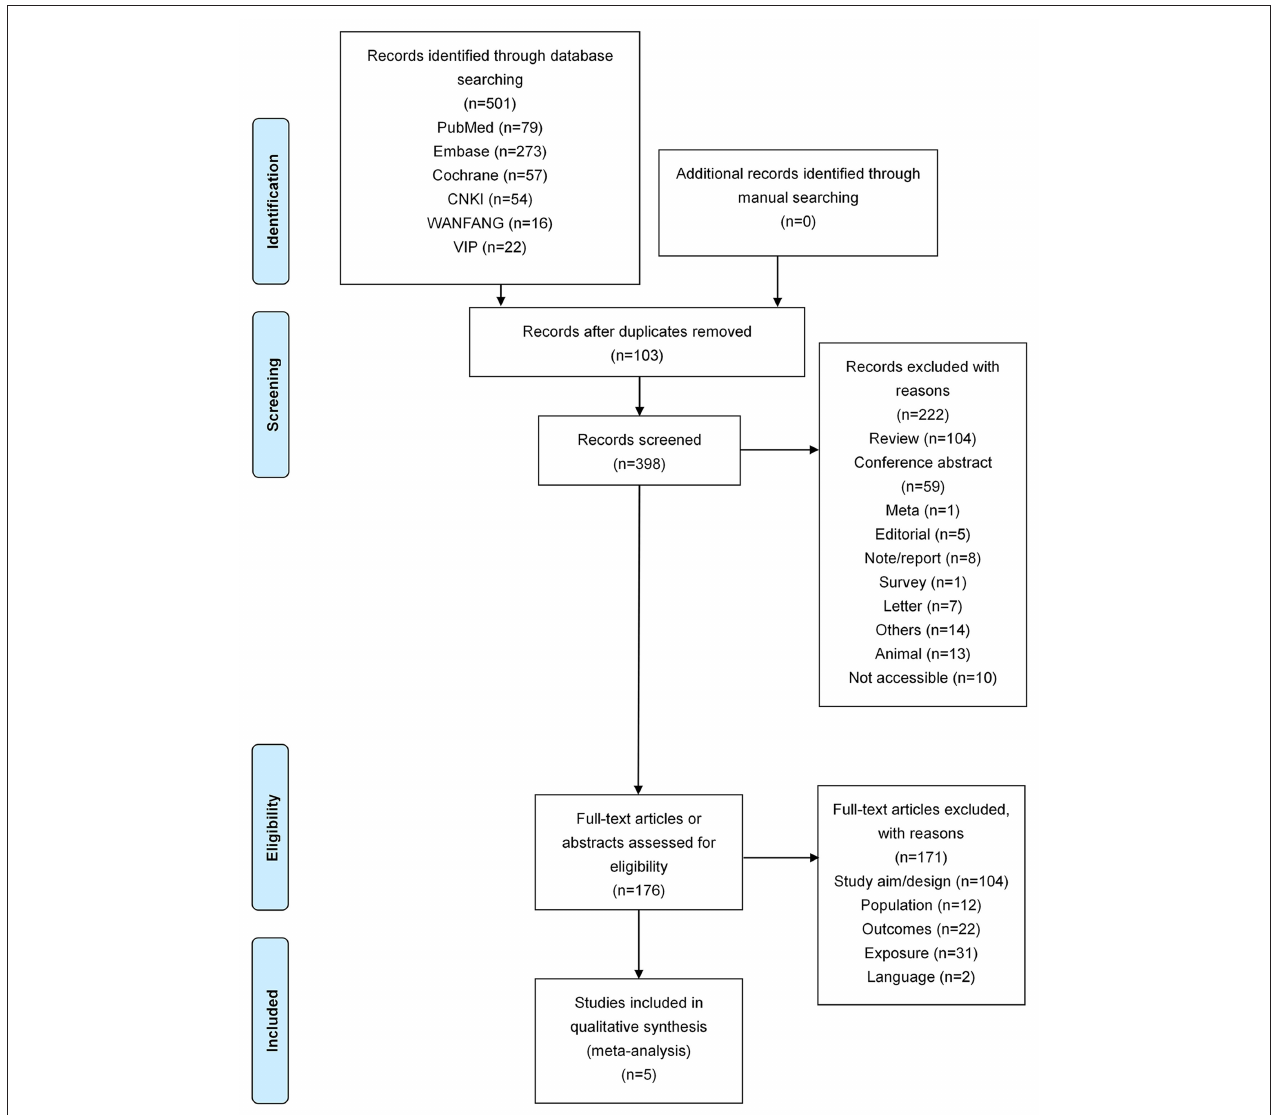
FIGURE 1 | Flow diagram of the study selection